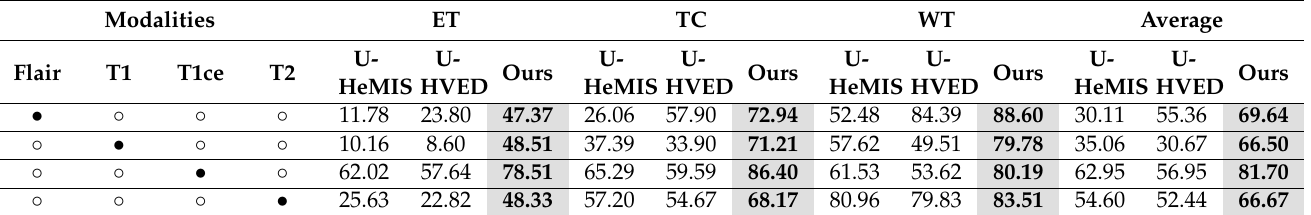
Table 1. Comparison of the proposed method with U-HeMIS [22] and U-HVED [23] methods on three nested sub-regions (ET, TC, WT). DSC is used as an evaluation metric. Existing modalities are marked with • , while missing modalities are marked with ◦ .